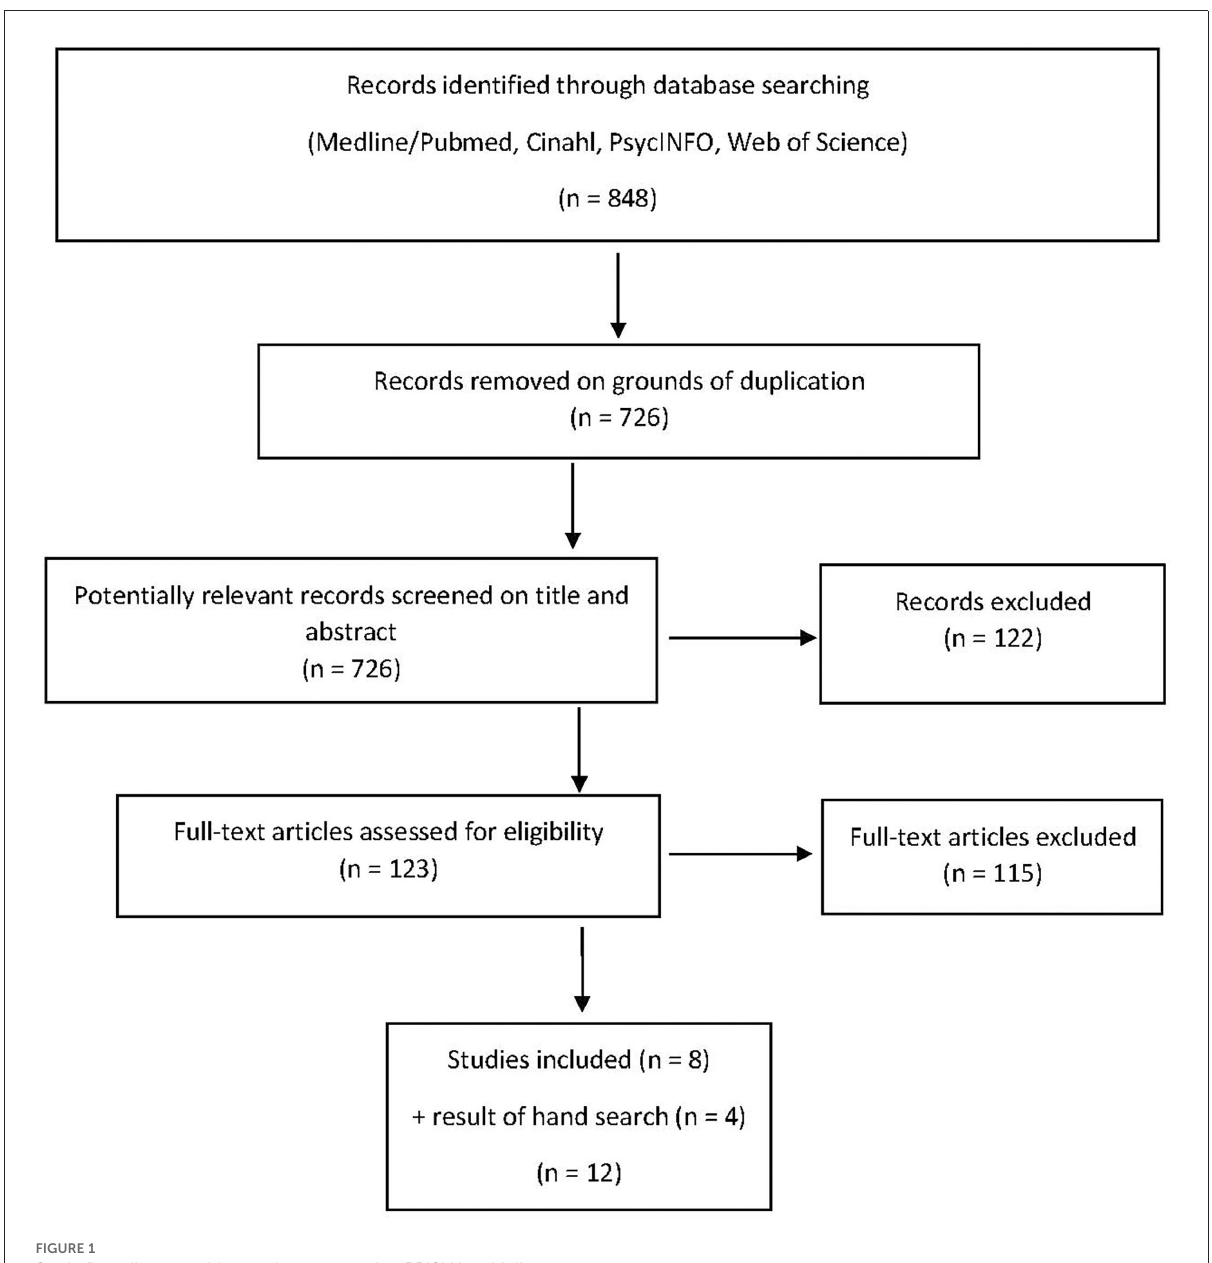
FIGURE1 Study flow diagram with search strategy using PRISMA